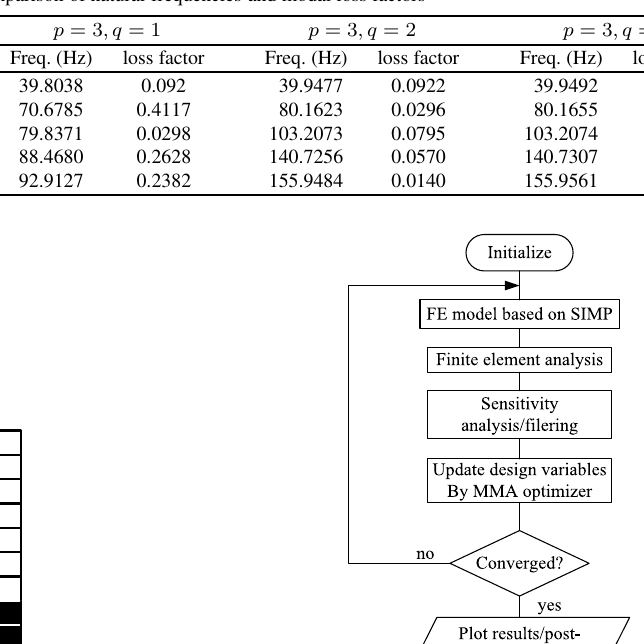
Table 2 Comparison of natural frequencies and modal loss factors